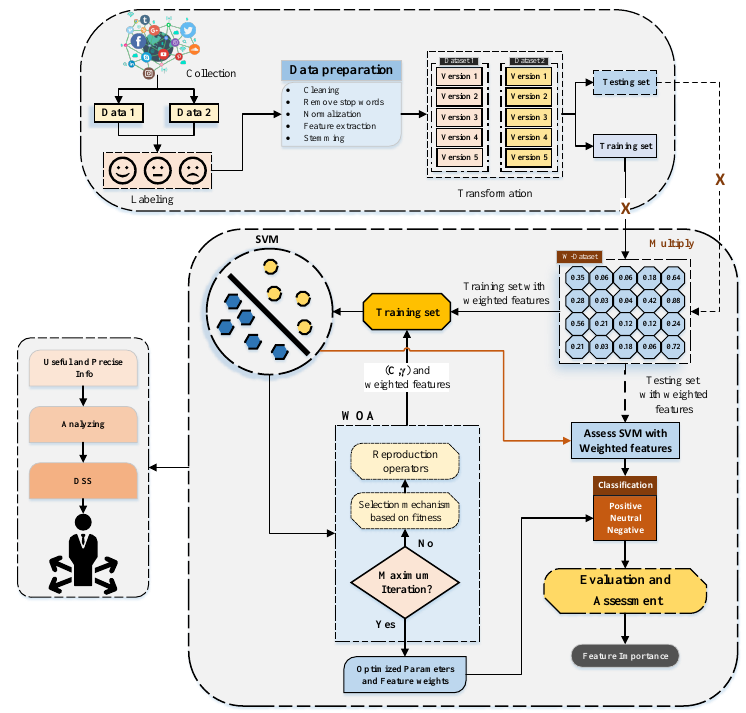
Figure 3. Detailed description of the